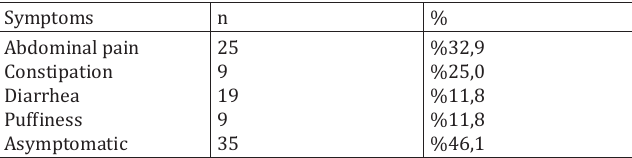
Distribution of symptoms during